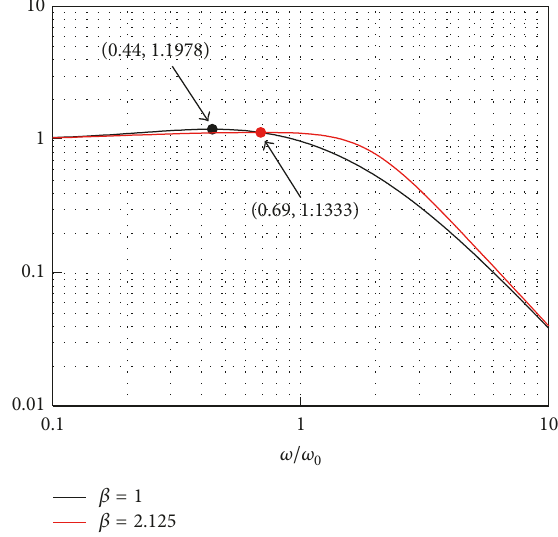
Figure 44: Transmissibility ( 𝛼 = 4, 𝛽 = 1, 2.215